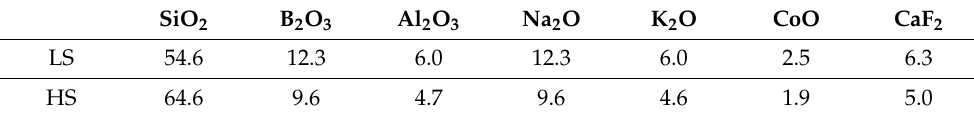
Table 1. Nominal composition of enamel (wt%). LS = low silica. HS = high silica. SiO